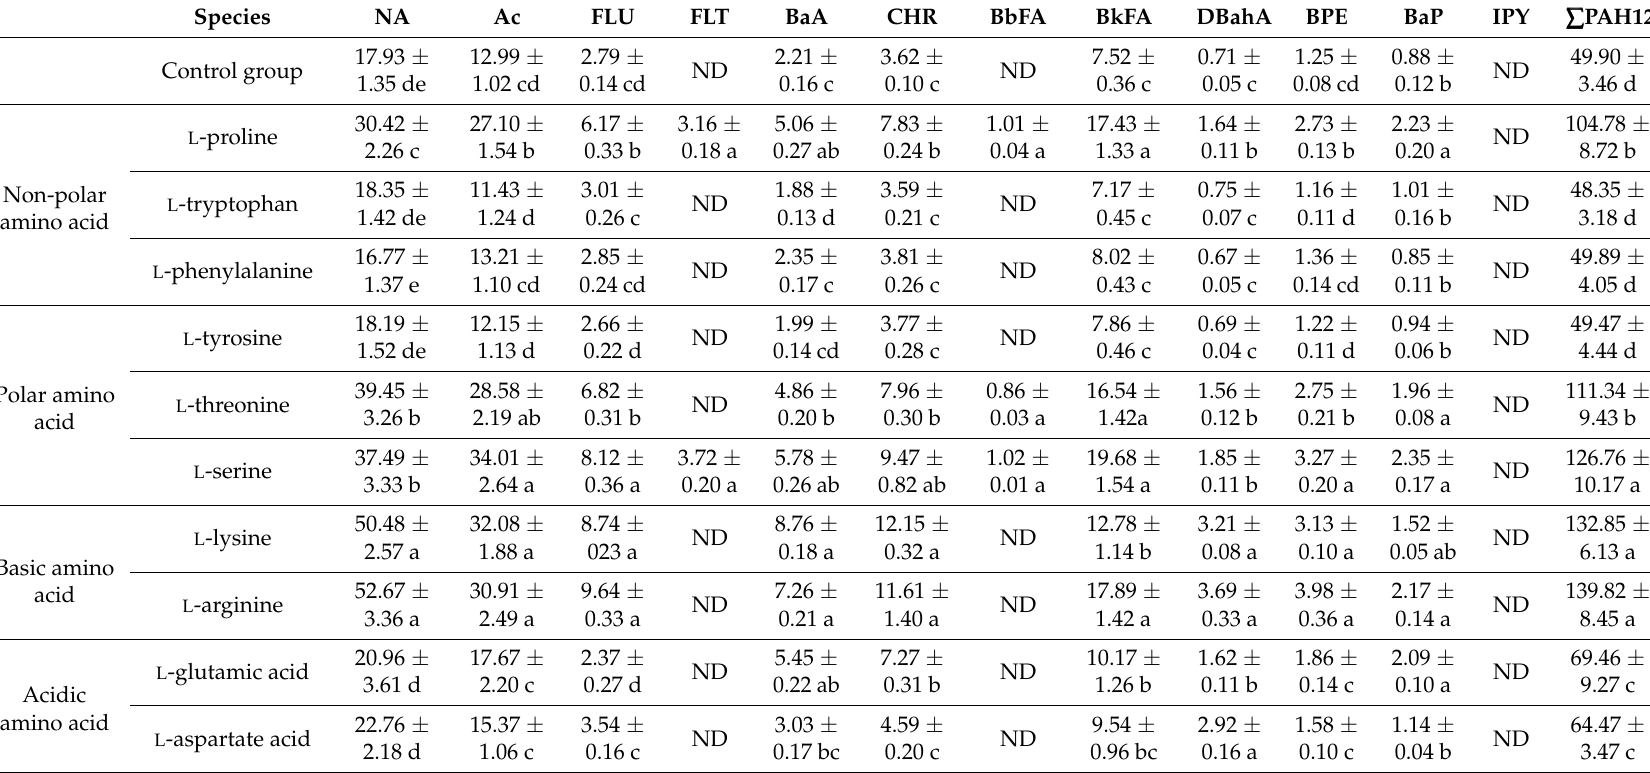
Table 3. Concentrations ( n = 3) of 12 PAHs produced as a consequence of adding different amino acids to grilled